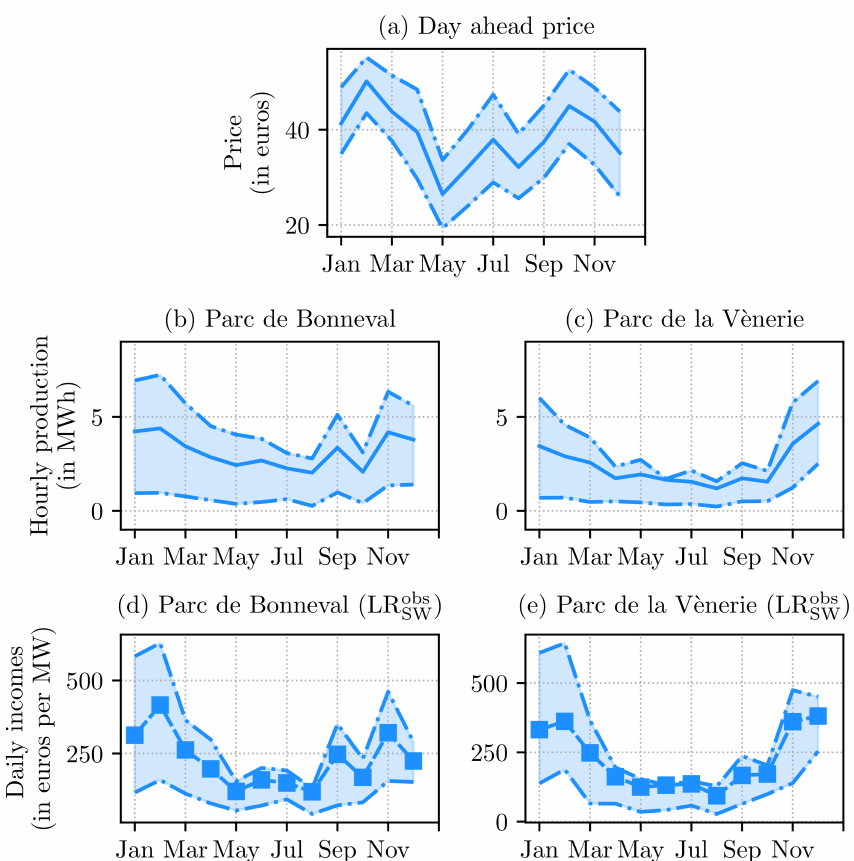
Figure 3. Panel ( a ): day-ahead price averaged over each month of the calendar year, together with the first and third quartiles for each month. Panels ( b , c ): wind energy production at Parc de Bonneval and Parc de la Vènerie, averaged over each month with first and third quartiles for each month. Panels ( d , e ): simulated daily income, computed with the LR obs nowcasting model, averaged over each SW month, with quartiles for each month. Data and results are shown for the year